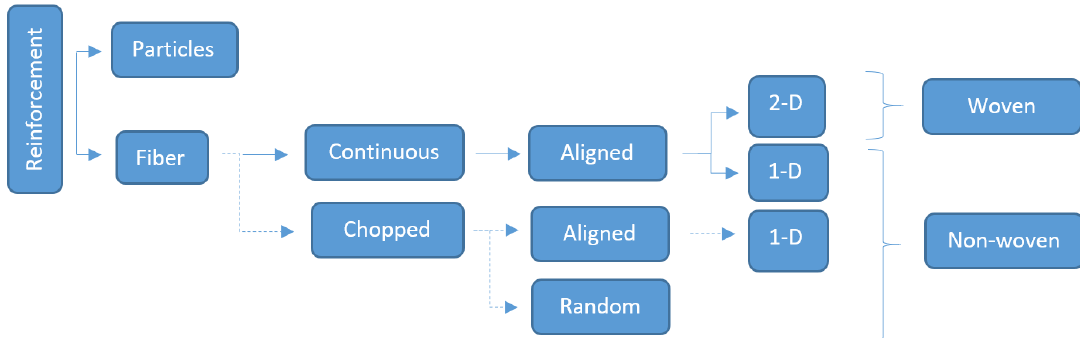
Figure 2. Type of natural fibre reinforcements. Adapted from: [7,15].